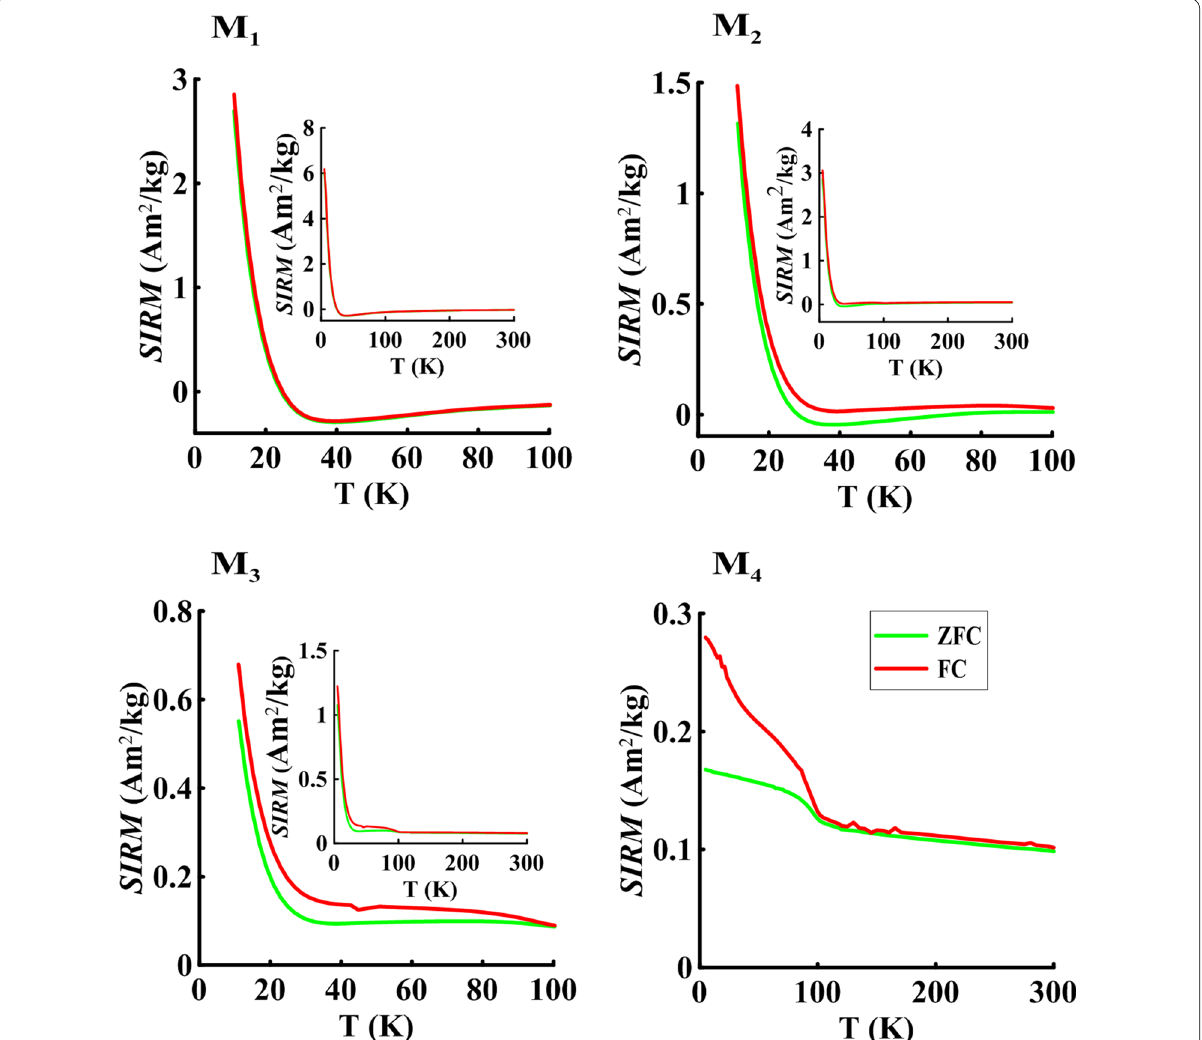
Fig. 6 Decay curves of saturation isothermal remanent magnetization acquired in a 2.5 T field after zero-field-cooling (ZFC) and field-cooling (FC)